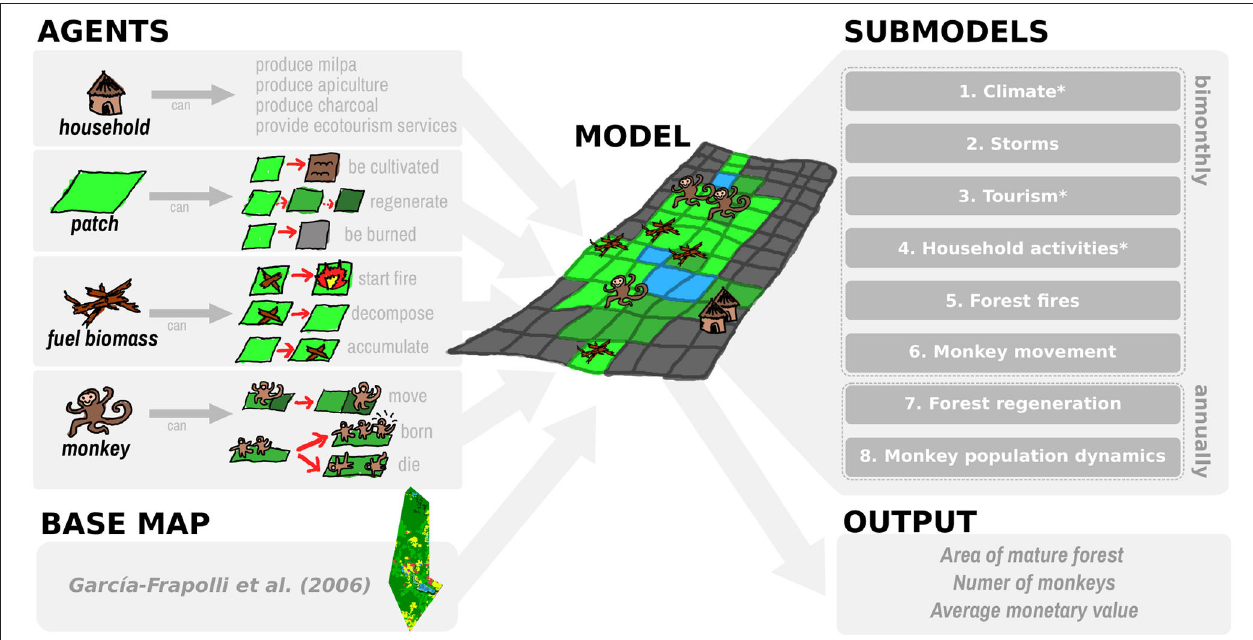
FIGURE 2 | Representation of the model. The model can be mainly understood as an agent based model composed of four different types of agents. The world where the agents interact is based on a land use and vegetation map. The model simulates eight different processes, or submodels, six of which occur every 2 months (each time step) and the last two only occur annually (each six time steps). The three submodels indicated with an asterisk (*) were modeled using boolean networks ( Supplementary Figure 1 ). The state of the modeled system is monitored through three output